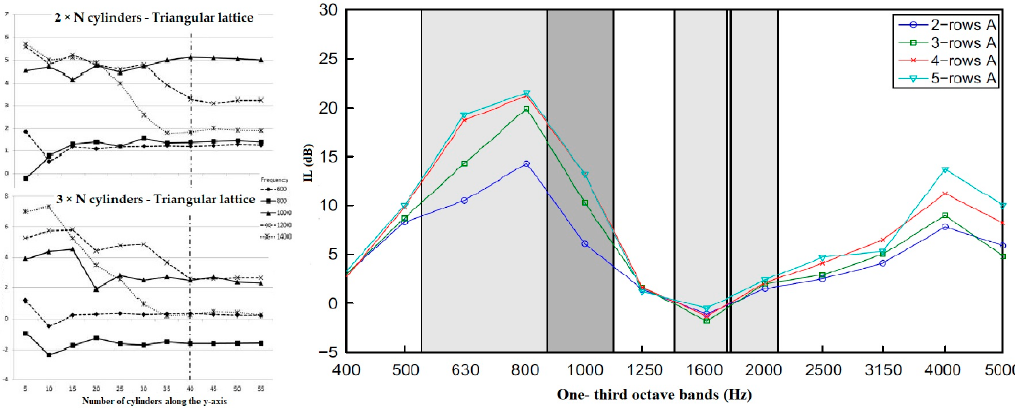
Figure 5. Influence of scatterer number on absorption, modified from [35] and [49].